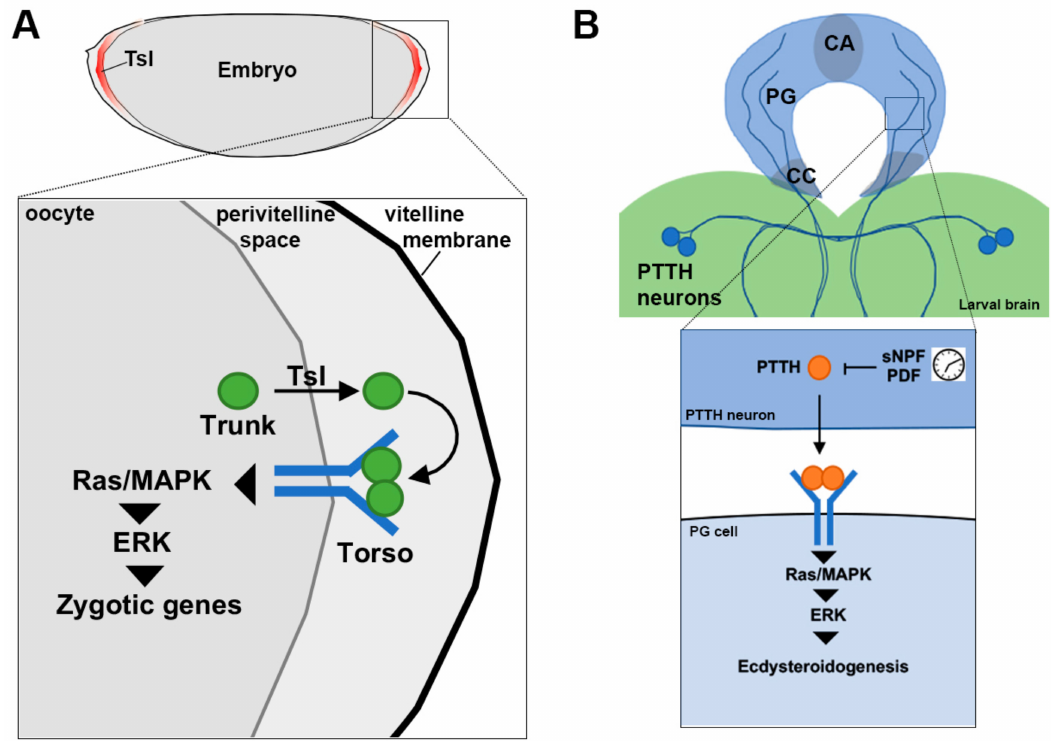
Figure 3. Torso signaling in embryonic patterning and the timing of developmental transitions. ( A ) Activation of Torso by its ligand Trunk at the termini of the early embryo triggers the de-repression of zygotic target genes and the specification of terminal cell fate. Torso signaling location is determined by Torso-like (Tsl), which is present only at the termini and is thought to permit the release of Trunk into the perivitelline space. ( B ) During larval development, Torso is activated by a second ligand, called PTTH, to trigger development transitions, including the initiation of metamorphosis. Torso is expressed in the major endocrine organ, the prothoracic gland (PG), which is directly innervated by two pairs of PTTH producing neurons from the larval brain. PTTH production and / or release is gated by clock neurons. Mitogen-activated protein kinase, MAPK; extracellular signal regulated kinase, ERK; corpus allatum, CA; prothoracic gland, PG; corpora cardiaca, CC; prothoracicotropic hormone, PTTH; short neuropeptide F, sNPF; pigment dispersing factor,